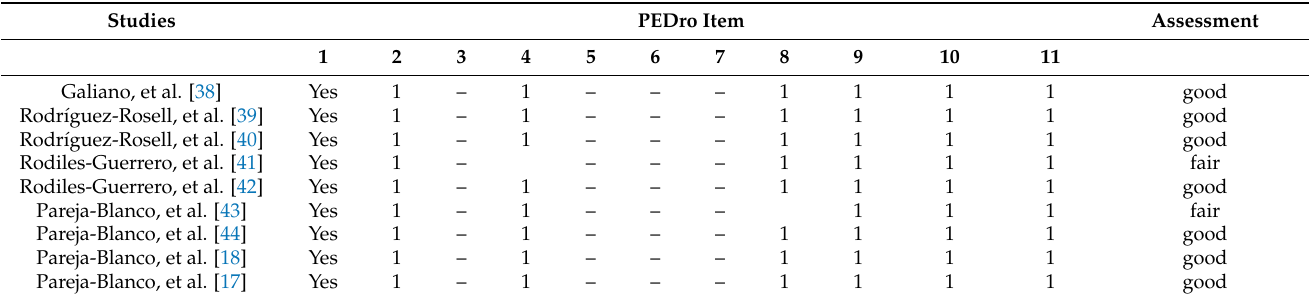
Table 3 . The risk of bias assessment for the included studies.